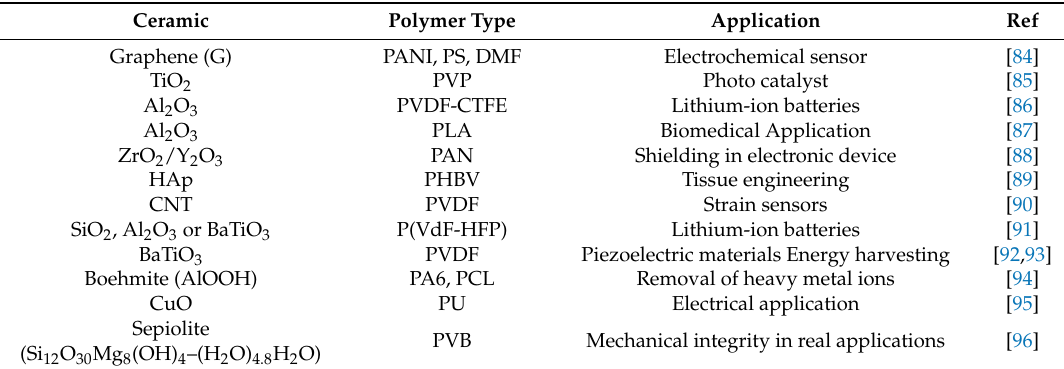
Table 2. Recent products of electrspun composite ceramic/polymer NFs and their